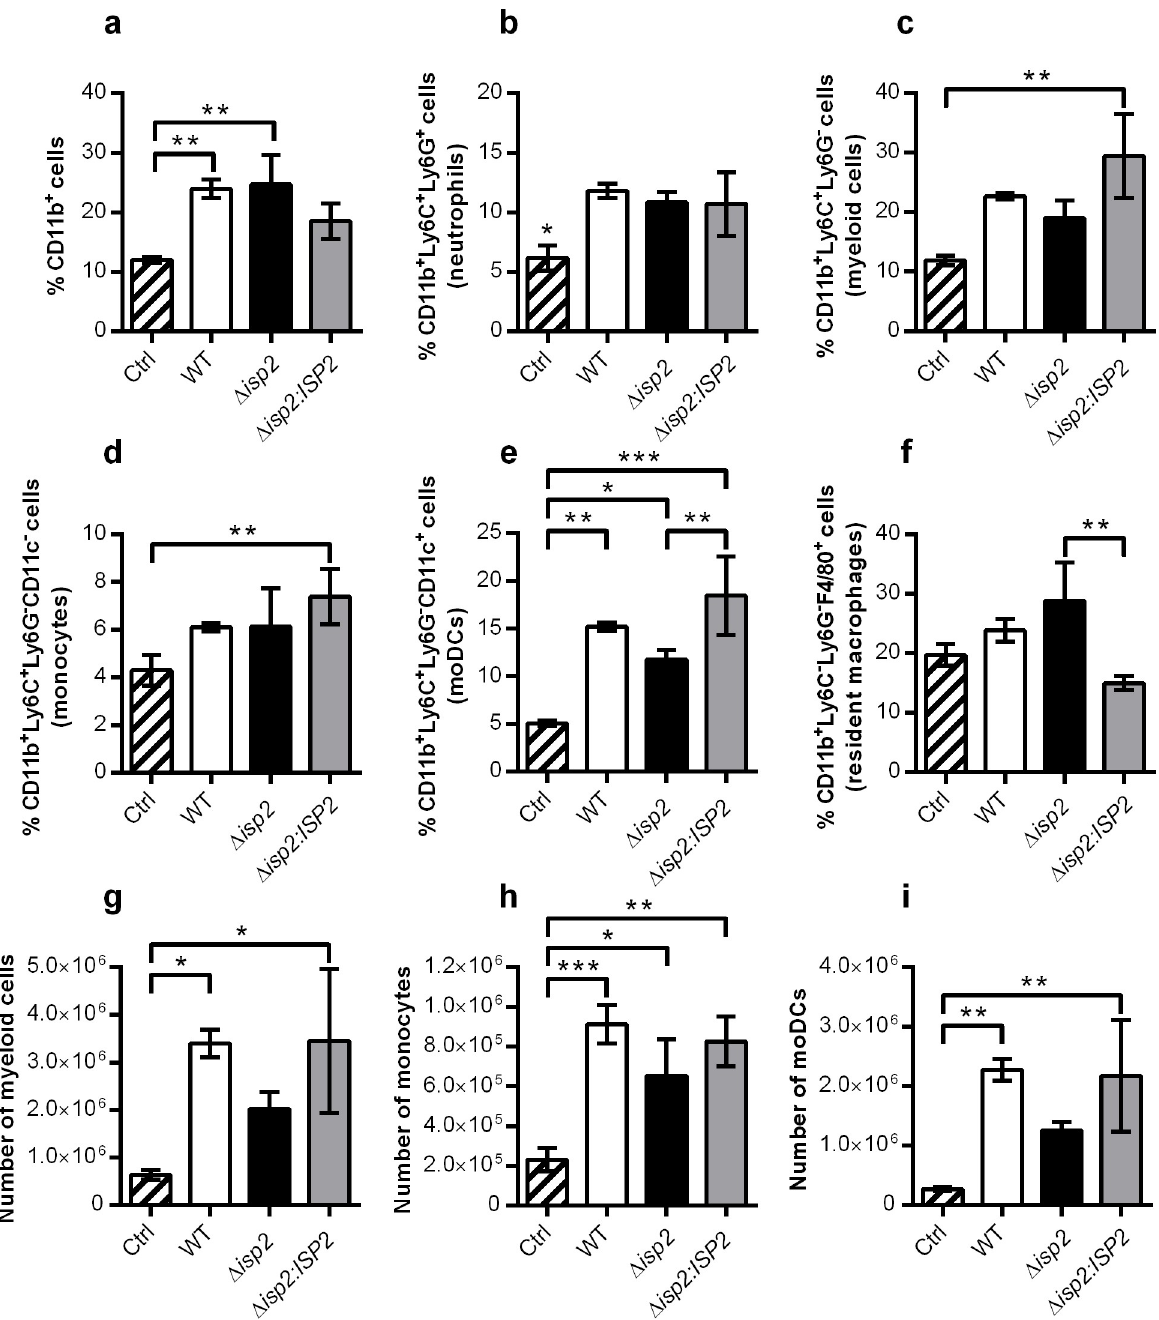
Fig 6. Distribution of innate cellular sub-populations in the spleen during early infection. C57BL/6 mice were infected intraperitoneally with 1 × 10 5 T . b . rhodesiense WT, Δ isp 2 and Δ isp 2: ISP 2.Uninfected mice were used as a control (Ctrl). After 4 days, mice were euthanized, perfused, and the spleens were removed and homogenized. Cell suspensions were then stained with antibodies for extracellular markers for flow cytometry to assess cell subsets. Cells were first gated to exclude debris using the FSC vs. SSC plot, followed by FSC-H vs. FSC-A to exclude doublets. CD11b + cells were selected from a SSC vs. PE-CD11b plot. From the CD11b + cells, a BV605-Ly6C vs. APC-Ly6G plot was generated to identify neutrophils (Ly6C + Ly6G + ), resident cells (Ly6C - Ly6G - ) and myeloid (Ly6C + Ly6G - ) cells. From the resident cells, a histogram for FITC-F4/80 was used to identify F4/80 + cells in this subset. From the myeloid cells, a further plot using SSC vs. PerCP-Cy5.5-CD11c was used to identify CD11c - and CD11c + cells. Gating strategies are shown in S3 Fig. Graphs show the percentage of (a) CD11b + cells, (b) CD11b + Ly6C + Ly6G + cells (neutrophils), (c) CD11b + Ly6C + Ly6G - (myeloid cells), (d) CD11b + Ly6C + Ly6G - CD11c - (monocytes), (e) CD11b + Ly6C + Ly6G - CD11c + (monocyte-derived dendritic cells, moDCs) and (f) CD11b + Ly6C - Ly6G - F4/80 + (resident macrophages), within the CD11b + population in the spleen. The number of (g) myeloid cells, (h) monocytes, and (i) monocyte-derived dendritic cells are also given. n = 3 mice per group. Results are presented as the